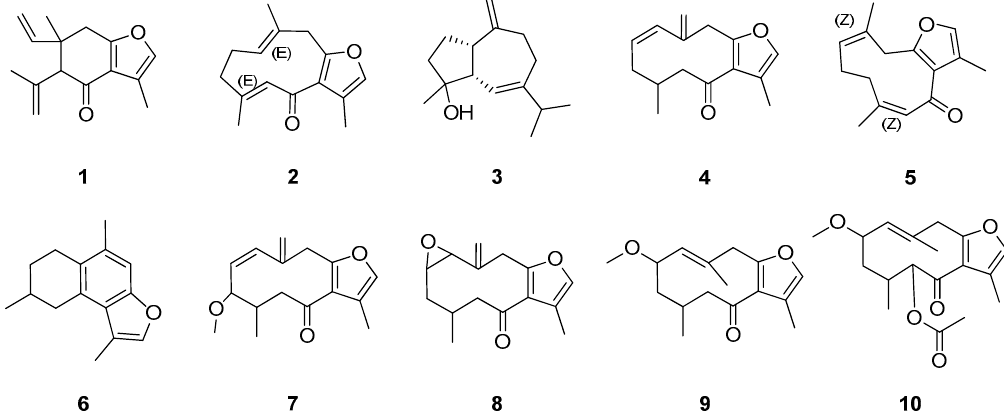
Figure 3. Structures of main constituents isolated from myrrh.